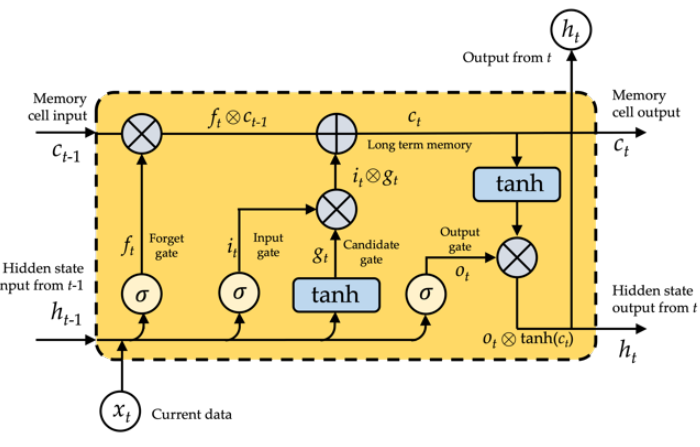
Figure 5. The LSTM